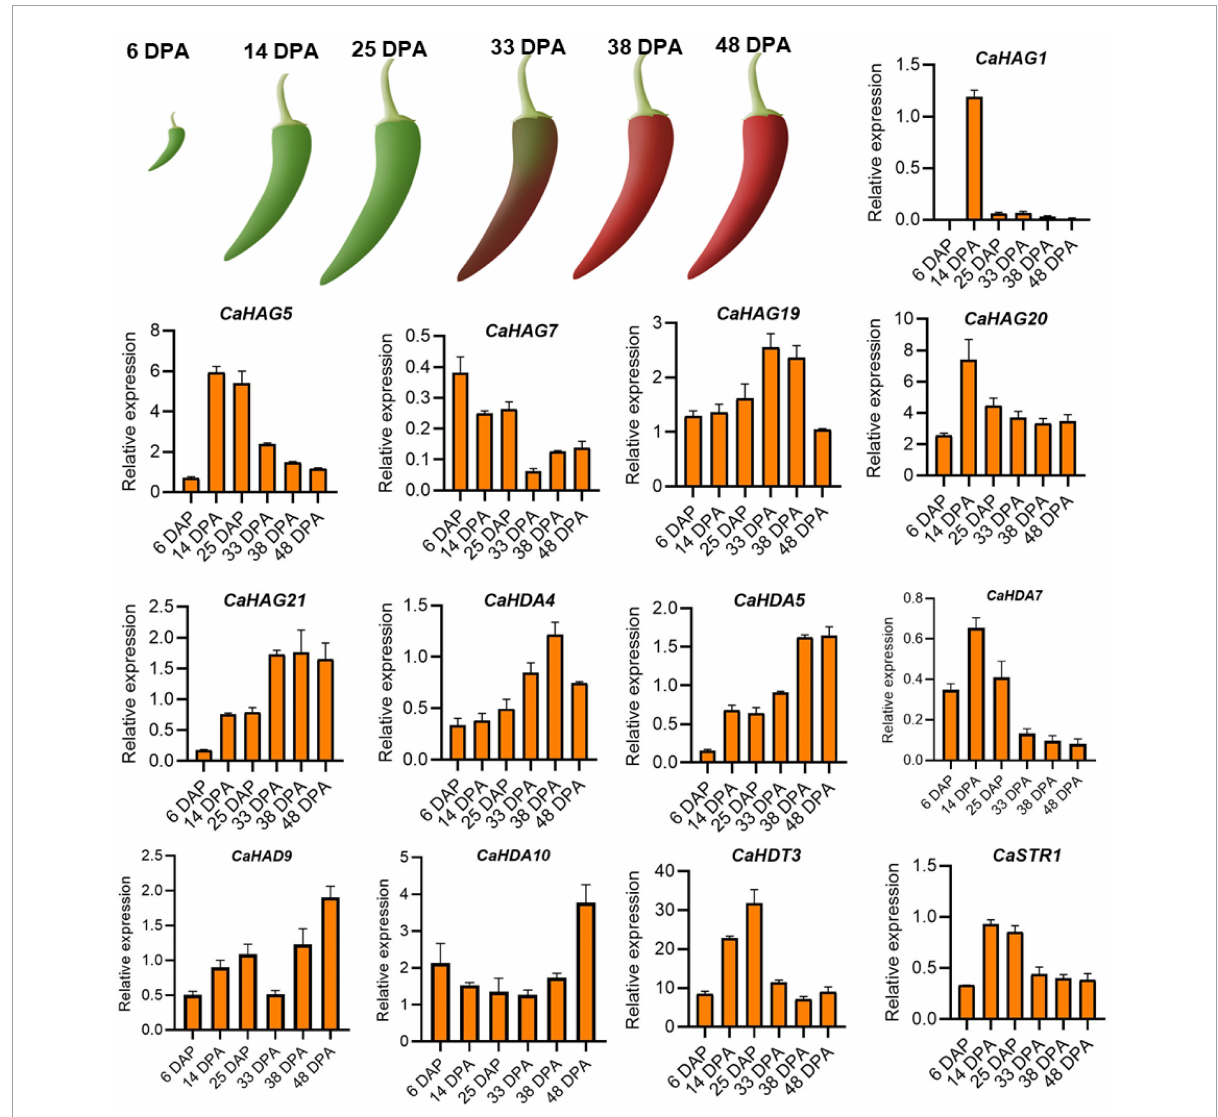
FIGURE7 qRT-PCR analysis expression patterns of 13 CaHAT and CaHDAC genes in different developmental stages of the fruit. The upper figure indicates schematic diagram of “59” inbred line fruit phenotypes at six developmental stages: 6, 14, 25, 33, 38, and 48 DPA. Bottom of figure indicates the expression of 13 selected CaHATs and CaHDACs expression patterns in fruit six developmental stages. Data are mean ± SE ( n = 3).